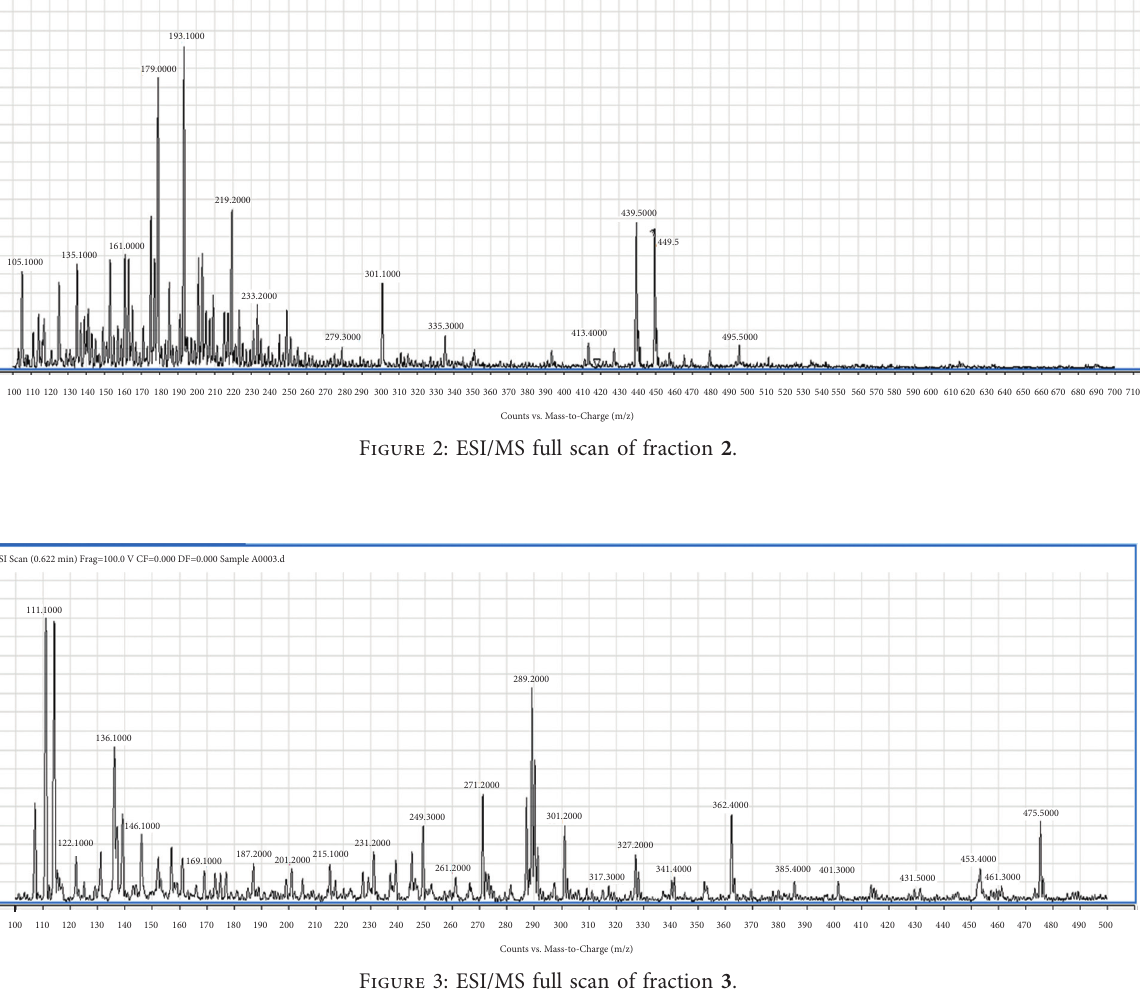
Figure 3: ESI/MS full scan of fraction 3 .